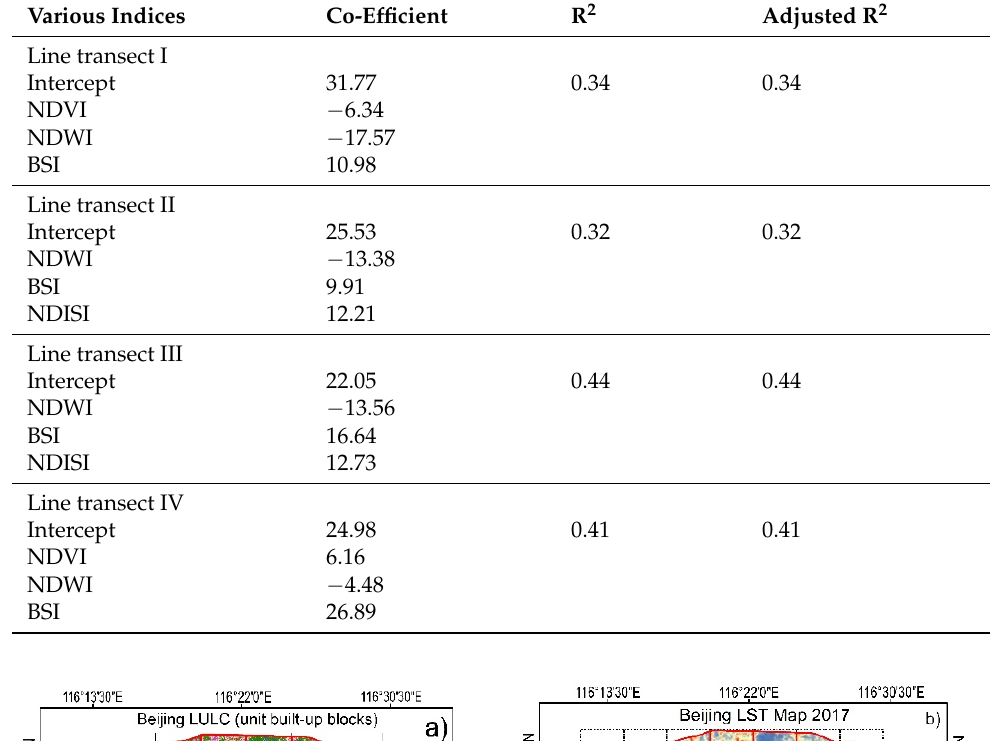
Table 7. Significant independent variables in modeling LST during stepwise regression.